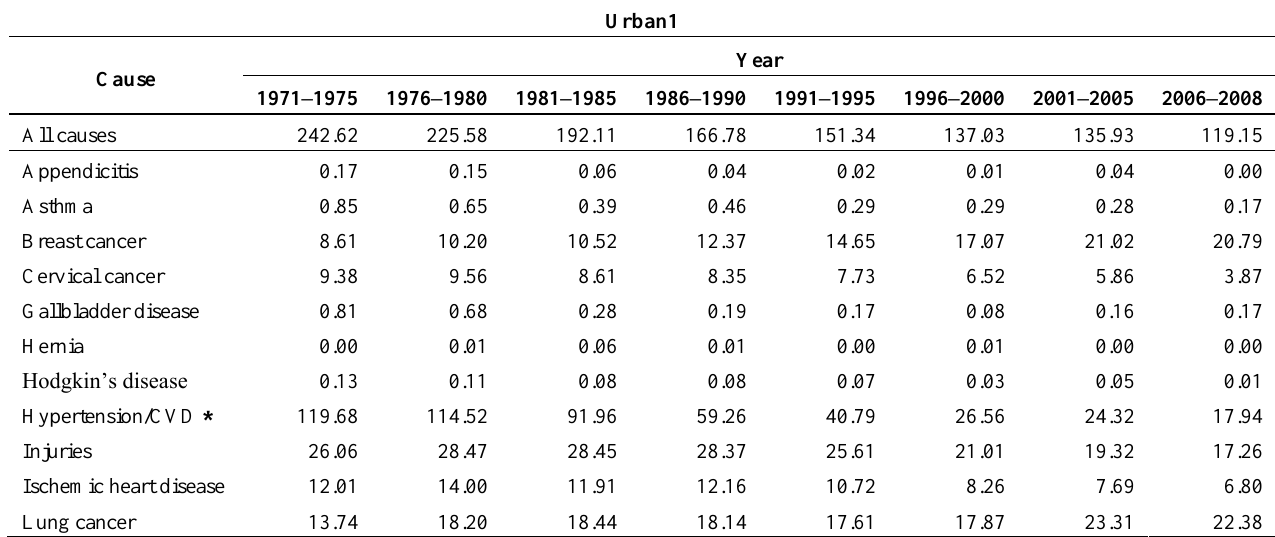
Table 1. Standardized mortality ratio (SMR per 100,000 people), females.